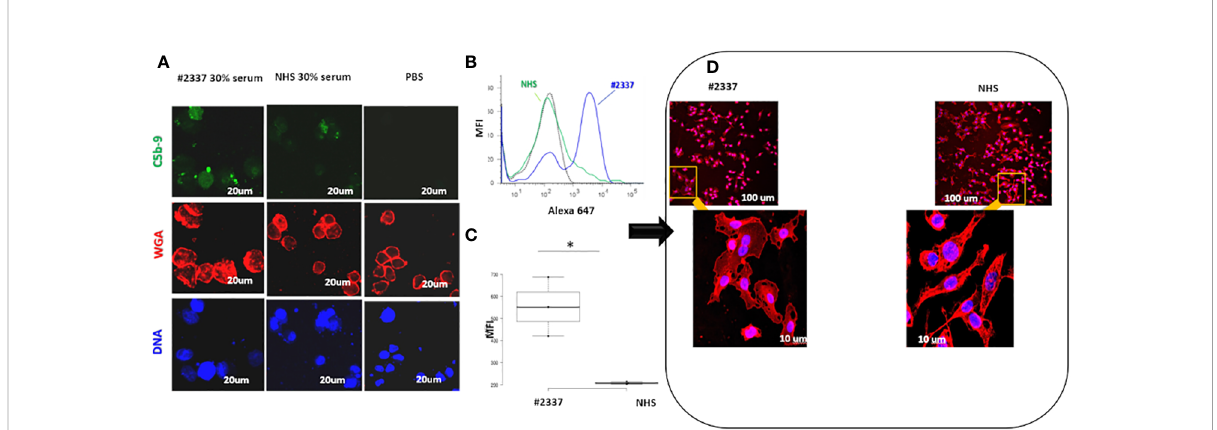
FIGURE 3 Low serum FHR2 levels result in enhanced C5b – 9 deposition on HUVECs, modifying cell morphology. (A) HUVECs incubated with 30% HS#2337 (Laser Scanning Microscopy, LSM) showed greater deposition of C5b – 9 (green fl uorescence) than cells that were incubated with 30% NHS. Nuclei were stained with 4 ′ ,6-diamidino-2-phenylindole (DAPI) (blue fl uorescence). The intact membrane was stained with wheat germ agglutinin Texas Red (WGA) (red fl uorescence). Scale bar, 20um. A result representative of three independent experiments is shown. (B) Fluorescence-activated cell sorting (FACS) con fi rmed the results obtained with LSM. HUVECs incubated with 30% patient serum lacking FHR2 showed greater C5b – 9 deposition than HUVECs incubated with NHS. MFI, mean fl uorescence intensity. (C) The boxplot displays the Mean Fluorescence Intensity (MFI) of HUVEC incubated with either the patient's serum (white) or NHS serum (grey). Data for the triplicate experiments is shown. * p < 0.05. (D) HUVECs were incubated with HS#2337 or NHS. Cell morphology was determined by examination of WGA fl uorescence using Laser scanning microscopy. Cells exposed to HS#2337 are retracted, losing their typical extended shape, and have more intracellular inclusions. Scale bar 100 m m and 10 m